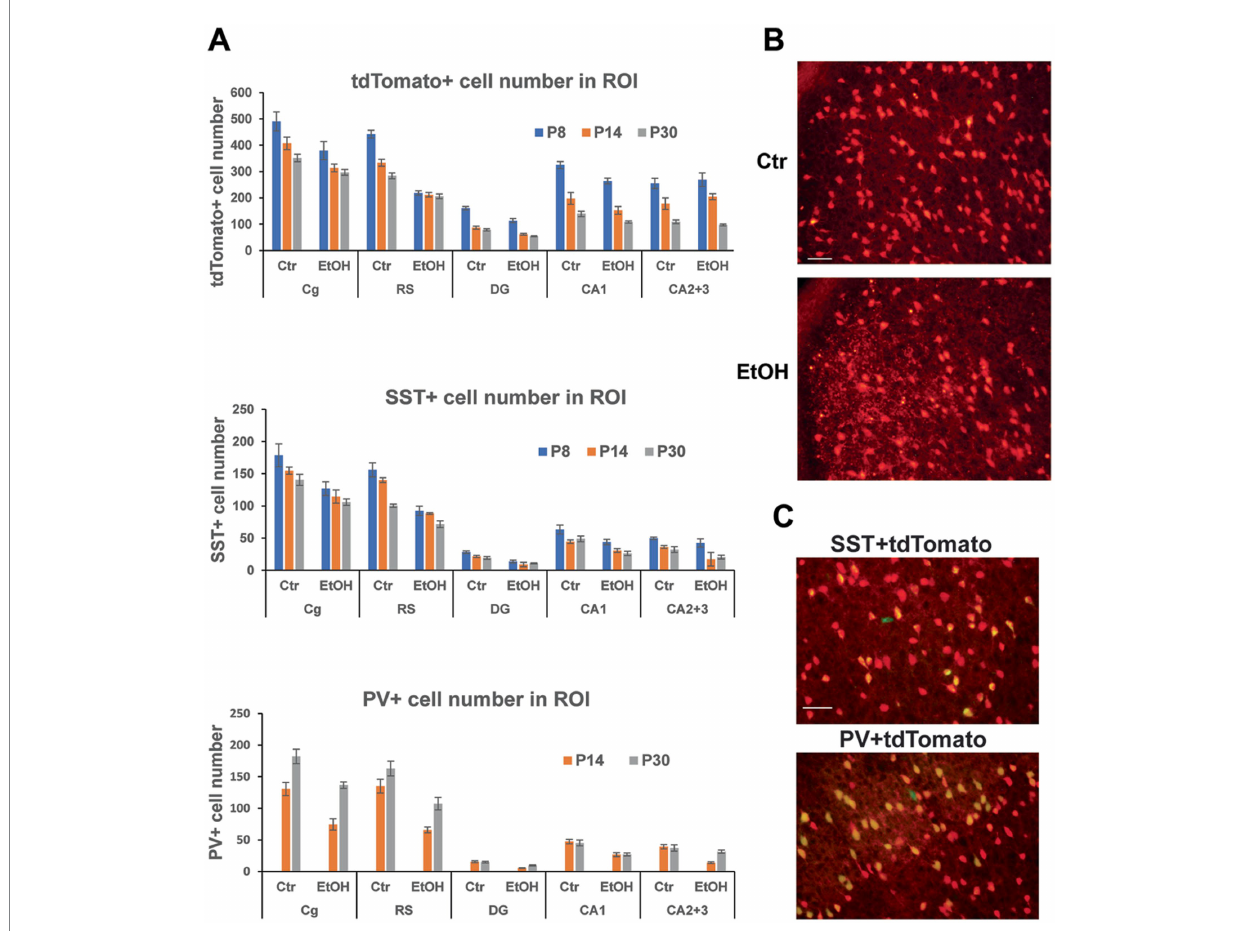
FIGURE 3 P7 ethanol induces long-lasting reduction in tdTomato+, SST+, and PV+ cells. (A) Nkx2.1-Cre;Ai9 mice were injected with saline (Ctr) or EtOH (2.5 g/kg, twice) at P7, and brains were perfusion-fixed at P8, P14, and P30 and vibratome-sectioned to count tdTomato+, SST+, and PV+ cell number in the cingulate cortex (Cg), retrosplenial cortex (RS), dorsal hippocampal dentate gyrus (DG), CA1, and CA2 + 3 regions by 2-dimensional counting. PV, which is barely expressed at P8 was only counted at P14 and P30. Mean ± SEM, n = 4. (B) 20 h after saline/EtOH treatment, Nkx2.1-Cre:Ai9 mice were perfusion- fixed, and brain sections were examined. EtOH treatment gave some cells neurodegenerative morphologies in RS. Scale bar = 50 μ m. (C) PV+ cells (labeled green) and SST+ cells (green) were primarily co-localized with tdTomato+ cells (red) in the cortex at P30. Scale bar = 50 μ